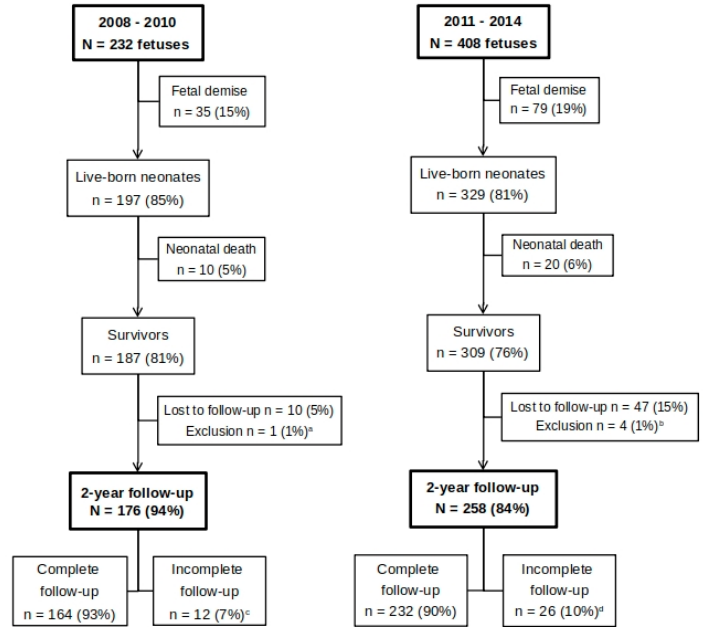
Figure 1. Flow chart of study population. a infantile Tay-Sachs disease; b n = 2: neurofibromatosis type 1, n = 2: familial severe hearing loss; c all 176 children were assessed by a pediatrician and physiotherapist; n = 5: only cognitive subtest of Bayley-III completed, no motor score; n = 7: neither cognitive nor motor subtests of the Bayley-III completed; d all 258 children were assessed by a pediatrician and physiotherapist; n = 8: only cognitive subtest of Bayley-III completed, no motor score; n = 2: only motor subtests of Bayley-III completed, no cognitive score; n = 16: neither cognitive nor motor subtests of the Bayley-III completed.